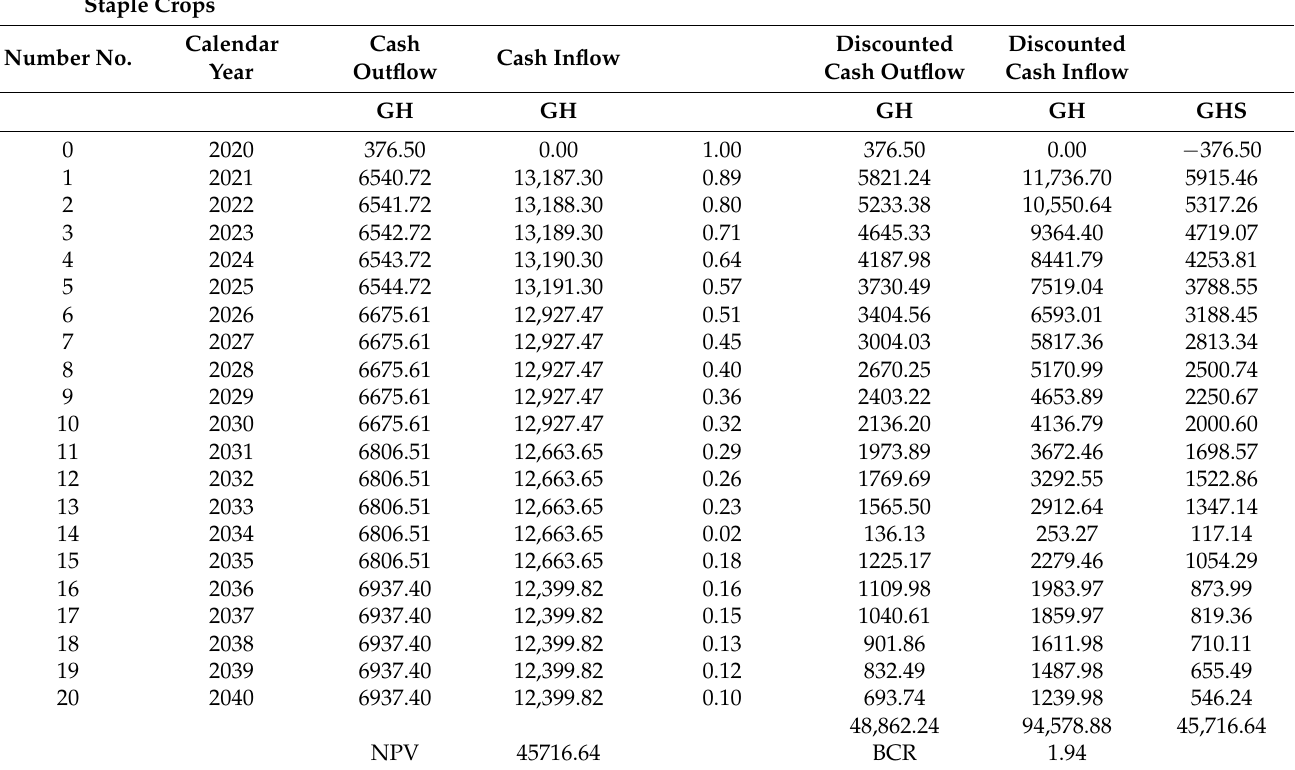
Table A4. NPV and BCR of farmers engaged in staple crop production.